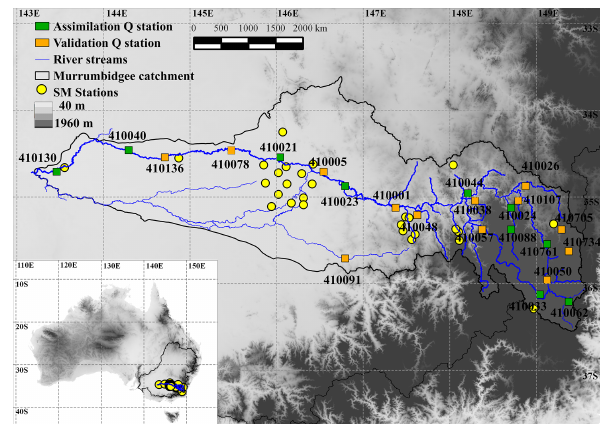
Figure 1. Map of the Murrumbidgee River basin and its location in Australia as part of the Murray–Darling system. Green squares indicate locations for assimilation of streamflow observations and orange squares indicate locations for evaluation of streamflow ob- servations. Each streamflow location is identified with a gauging station number according to BoM (2015). Yellow points indicate locations of field-measured soil moisture